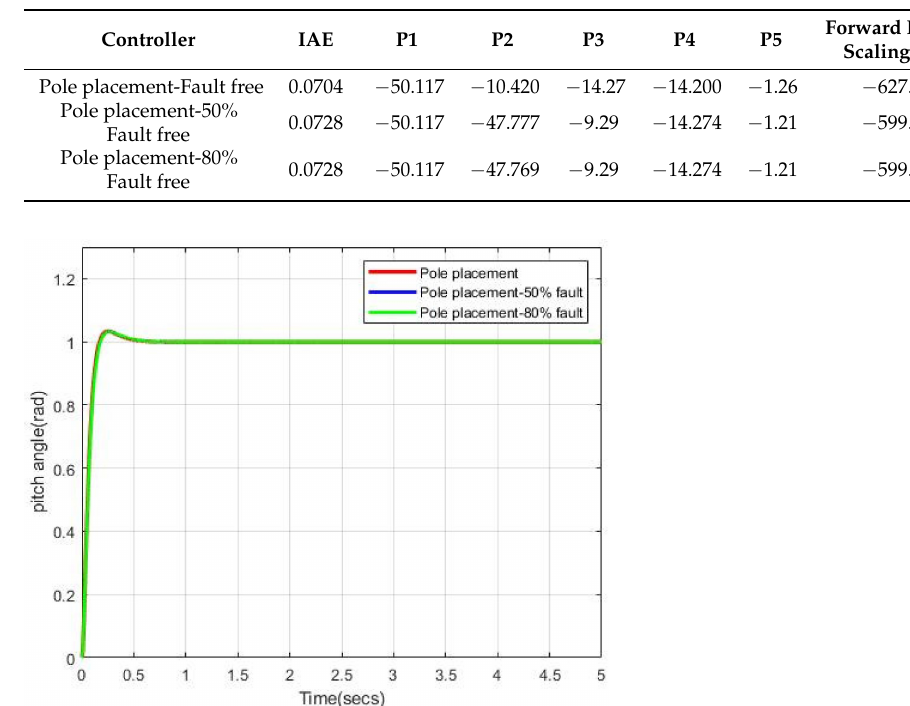
Table 2. Numerical performance results of the pole placement controller.